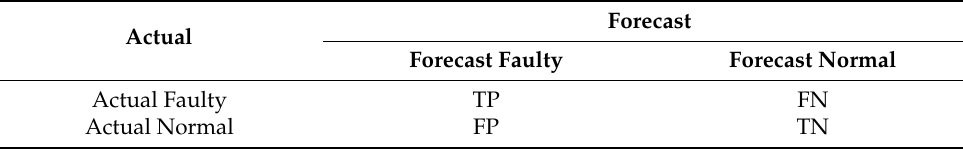
Table 4. Confusion matrix of classification